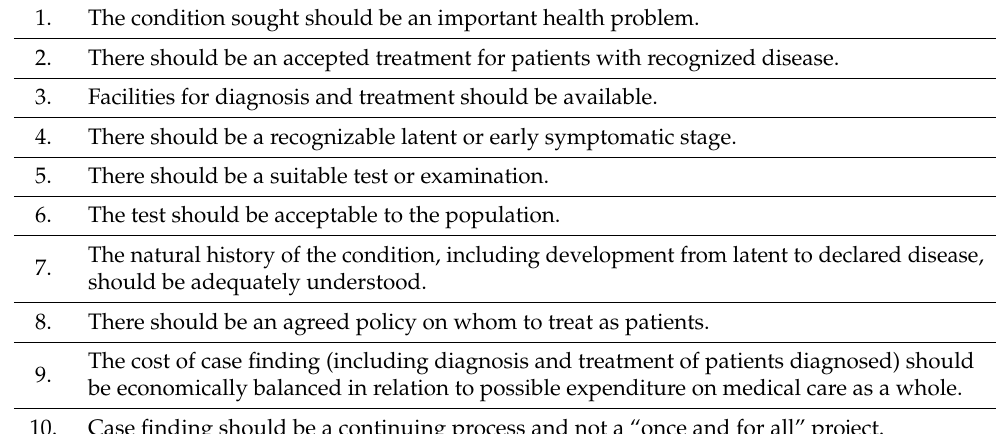
Table 1. Principles of screening by Wilson and Jungner